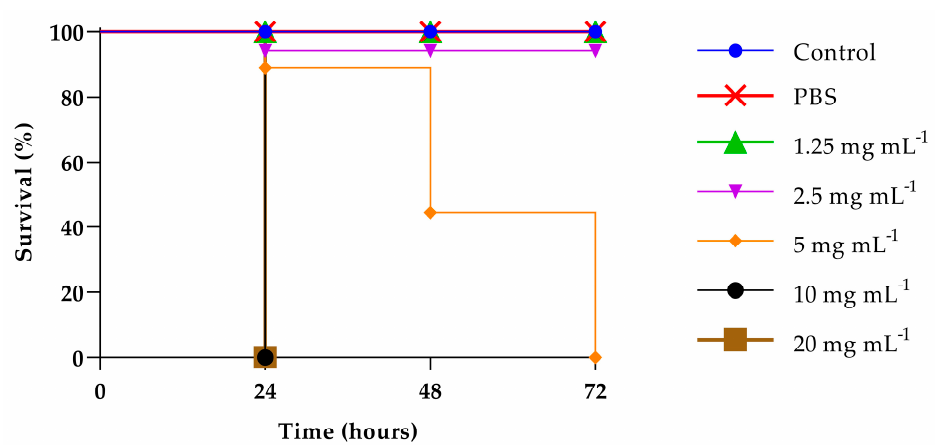
Figure 7. PLA toxicity on G. mellonella larvae treated with concentrations of 1.25 mg mL − 1 , 2.5 mg